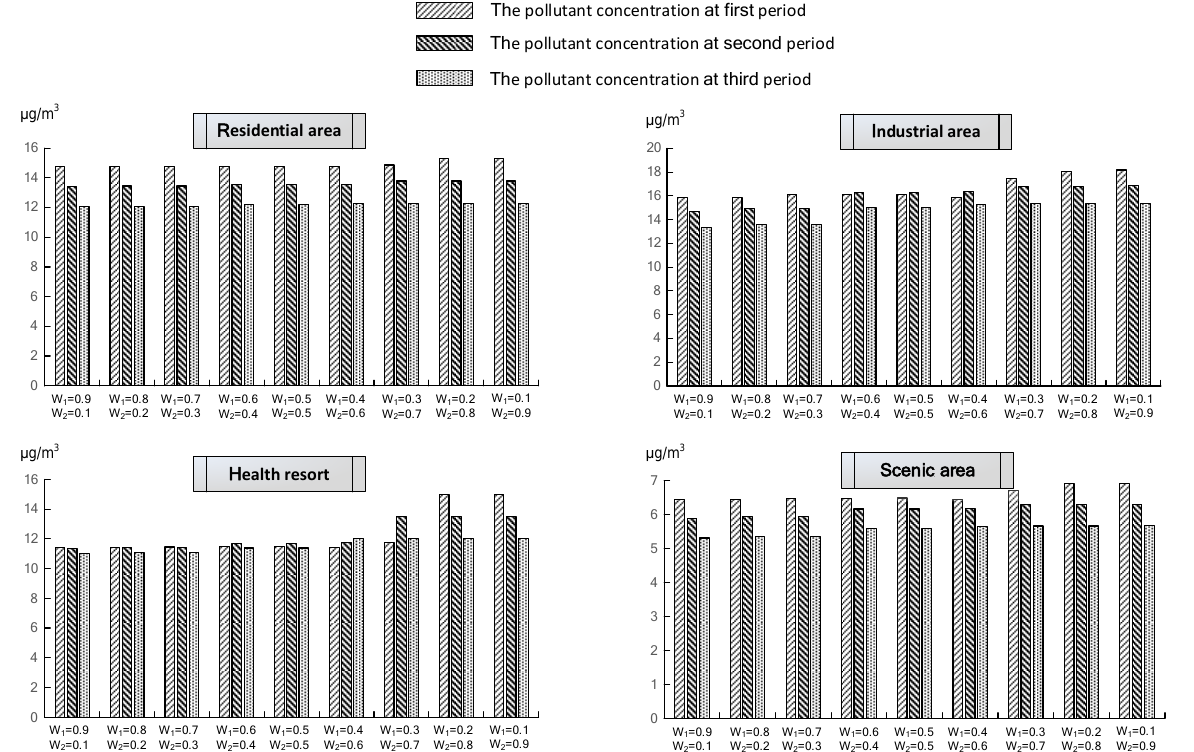
nomic growth. Therefore, the treatment scheme with high w 1 and low w 2 ( w 1 = 0.9 and w 2 = 0.1) is recommended for generating the pollution control strategies. This paragraph de- scribed the variation in two objective functions and analyzed the trade-off between system economy and health risk. Figure 4. The residual PM 2.5 concentration of four affected regions over three periods. In addition to decision variables, the influence caused by various weight combina- tions also affects the objective values. The variations in the death toll and total system cost under different weight combinations are depicted in Figure 5. It is evident that with the increase in w 2, the death toll exhibited a gradual increase from 80 to 122 Person. Con- versely, total system cost decreased from 37 to 26.58 × 10 4 USD, respectively. The above